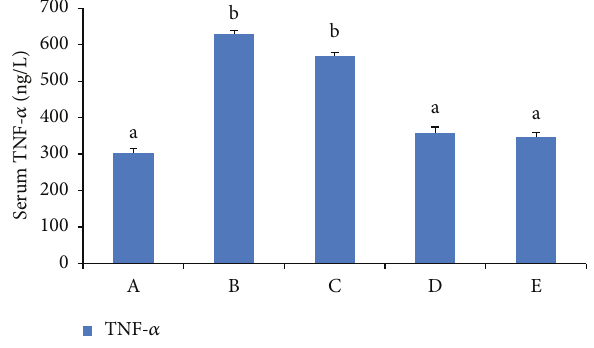
Figure 5: TNF in serum. Notes: (A) control group, (B) LPS group, (C) low dose of Baicalin (0.25 mg/mL), (D) middle dose of Baicalin (1.25 mg/mL), and (E) high dose of Baicalin (2.5 mg/mL). Different letters mean significant at 5% level, and same letters mean no significant difference.